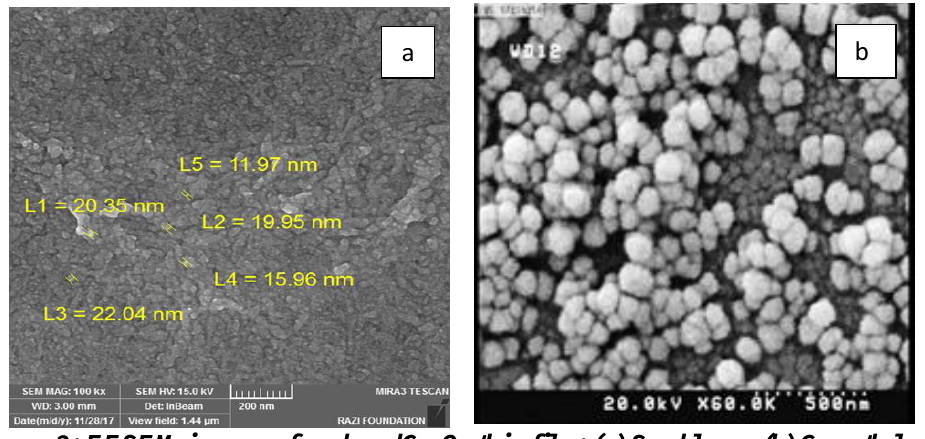
Figure 2: FESEM images of undopedCo